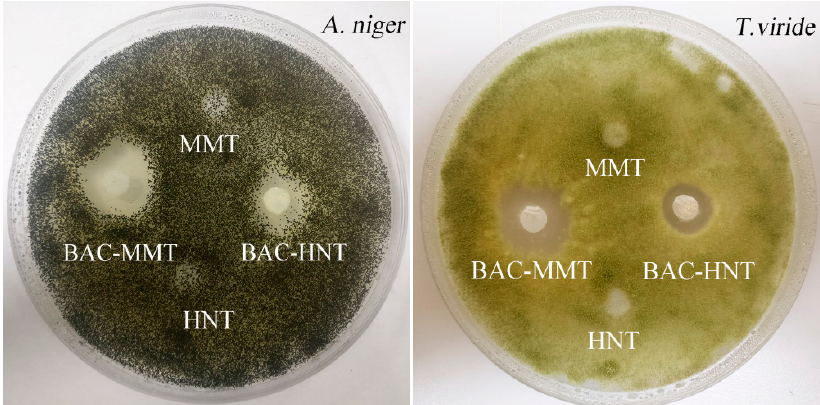
Figure 8. Inhibition zones of BAC-HNT and BAC-MMT against A. niger and T.viride .